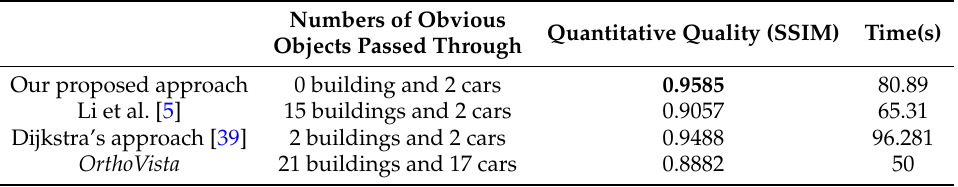
Table 3. The quality assessment of seamlines detected by our proposed approach, the approach proposed by Li et al. [5], Dijkstra’s approach and OrthoVista in the Figures 9 and